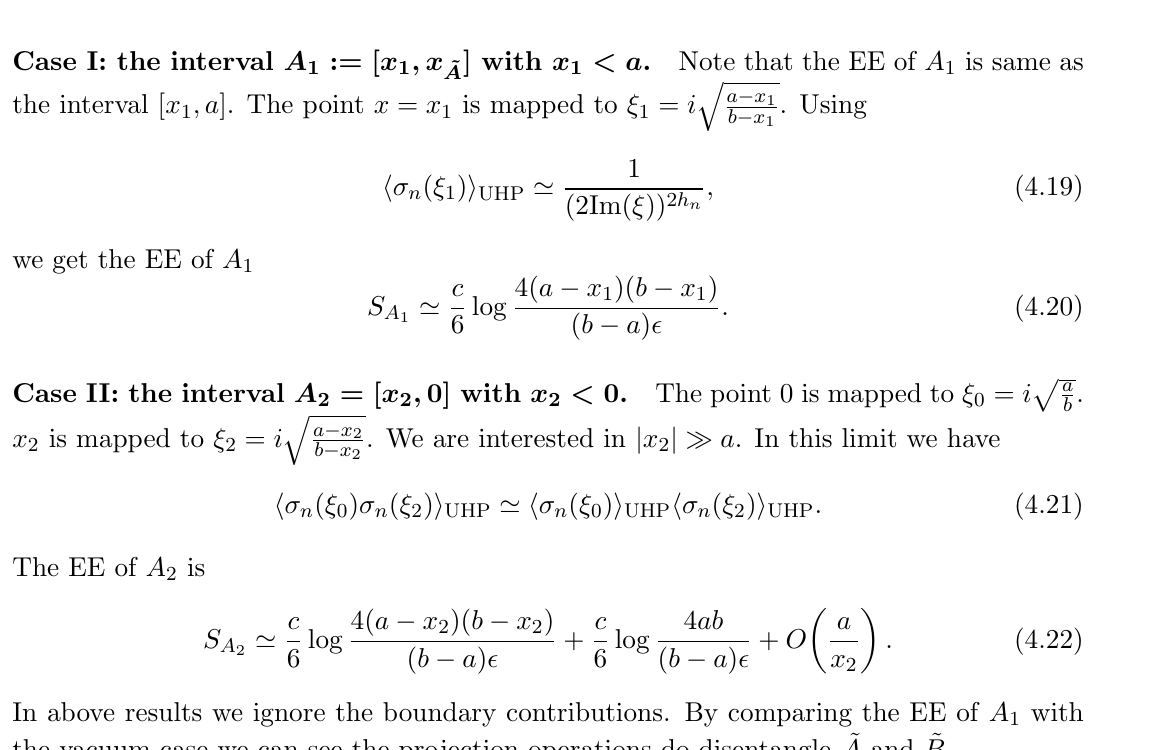
Figure 4 . Path-integral representation of the state j i P